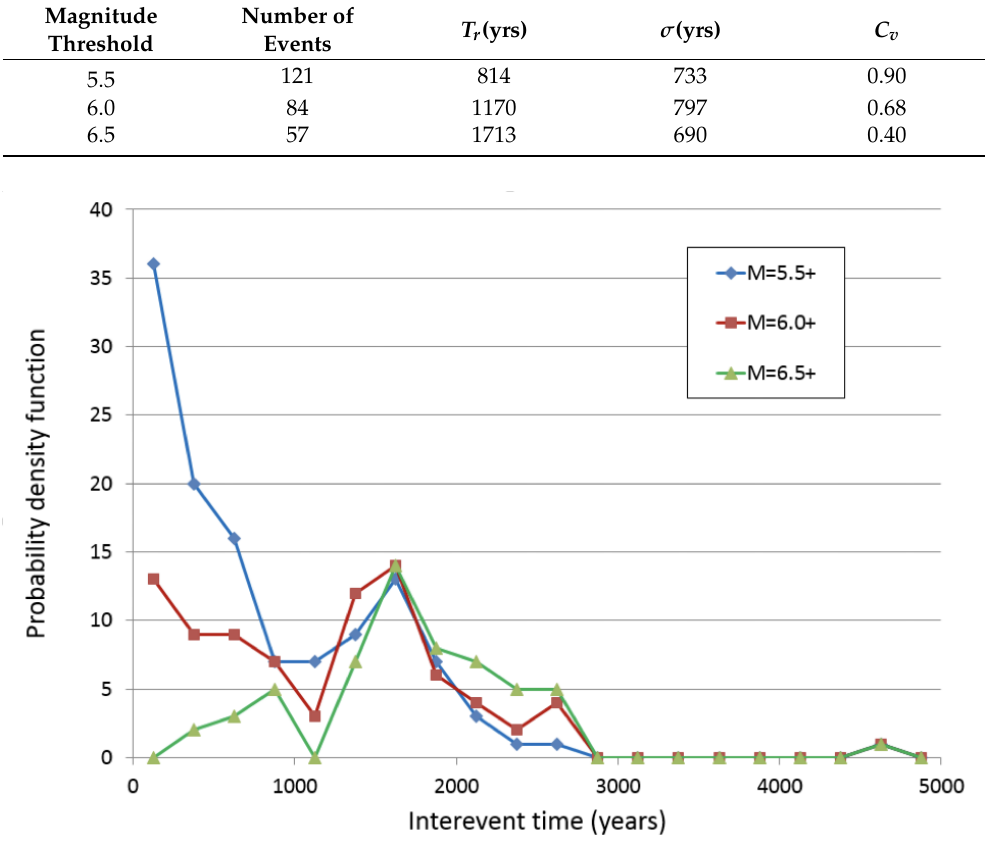
Figure 3. Density distributions of the number of inter-event times in bins of 250 yrs. The first bin corresponds to the range of 0–250 yrs and so